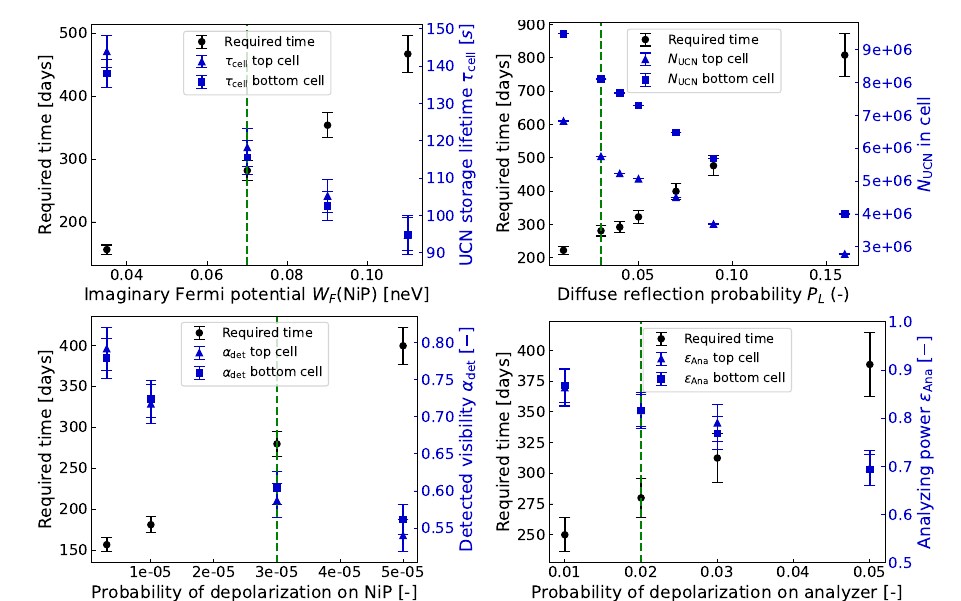
Figure 5. Four PENTrack sensitivity studies showing the required measurement time to reach a sta- tistical sensitivity of 10 − 27 e cm (1 σ ) and a selected other parameter for each plot. Our parameter assumptions are indicated by the vertical green lines. For more information, please refer to the